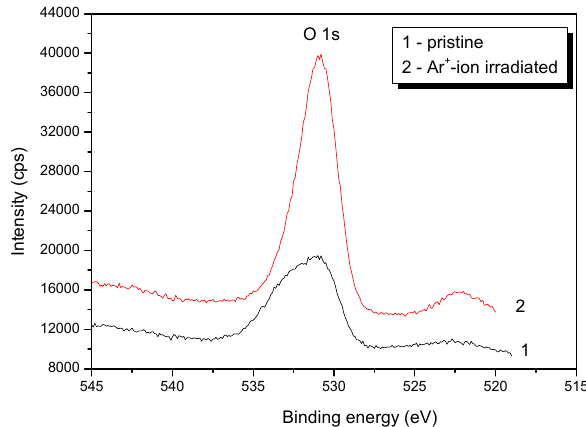
Figure 6. Panoramic XPS spectra of the investigated specimen before (1) and after (2) cleaning its surface with Ar + ions.